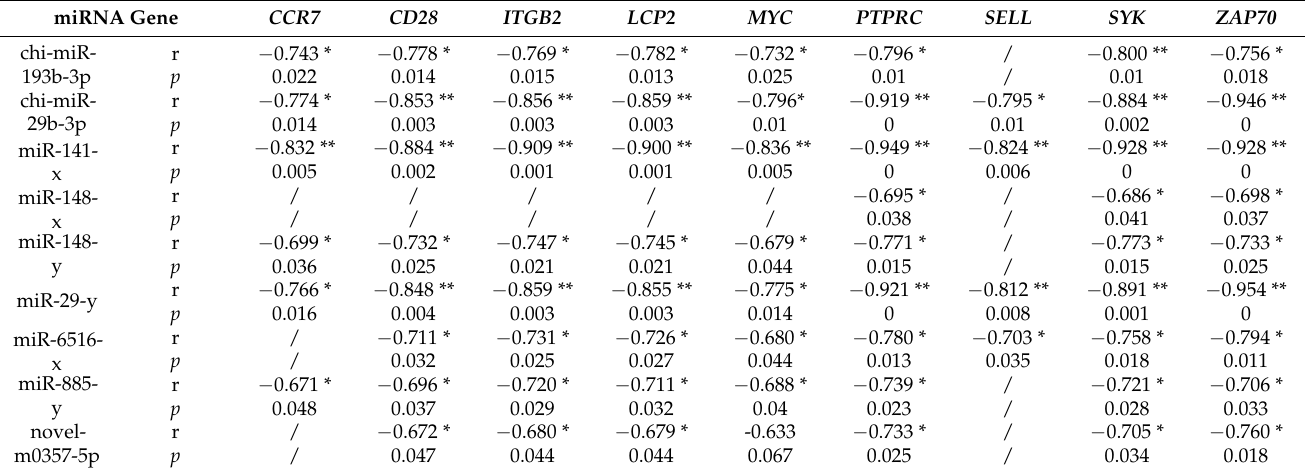
Table 9. The negative correlation expressed between miRNAs and core